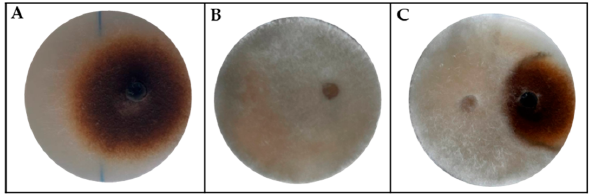
Figure 2. Competitive exclusion between pathogen fungi that infect the same host plant. ( A ) Alternaria alternata ; ( B ) Botrytis cinerea ; ( C ) Inhibition plate.